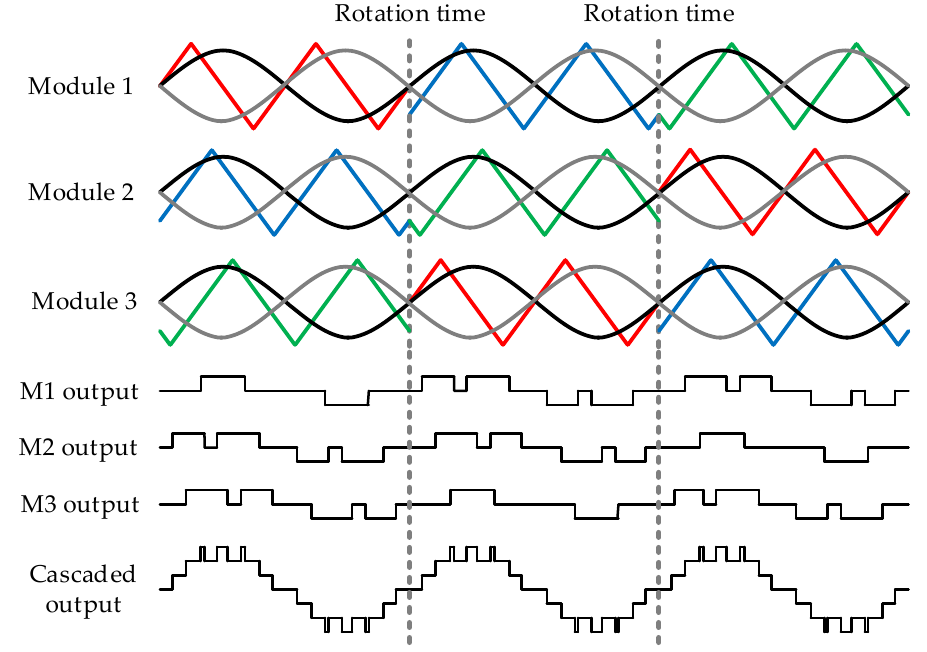
Figure 8. CPRS ‐ PWM scheme with rotation time at reference zero ‐ crossing point. Figure 8. CPRS-PWM scheme with rotation time at reference zero-crossing